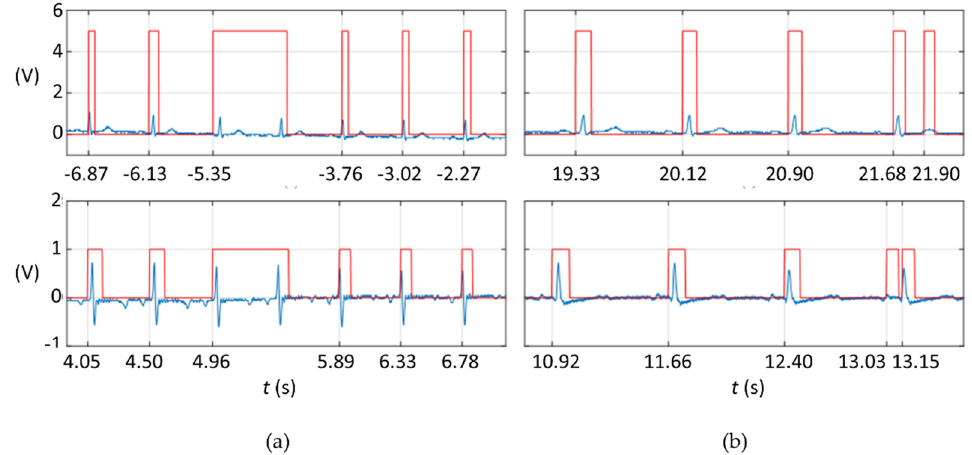
Figure 5. ECG (blue) and TTL (red) signals showing ( a ) false negatives when using the ECG from a moving human patient (top) and from an anesthetized swine specimen (bottom). ( b ) False positives using human (top) and swine (bottom) spec- imens. Table 1. Quantification of the errors that occurred for every trace measured (# stands for “num- ber”).